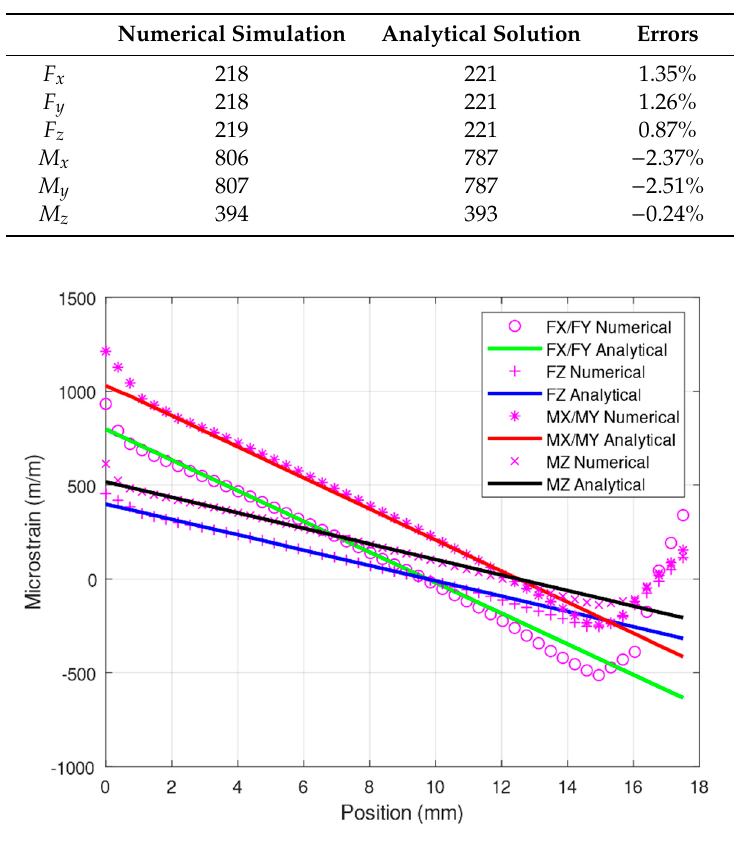
Figure 11. Comparison of numerical and analytical solutions under F x / F y , F z , M x / M y , and M z of elastic beams.